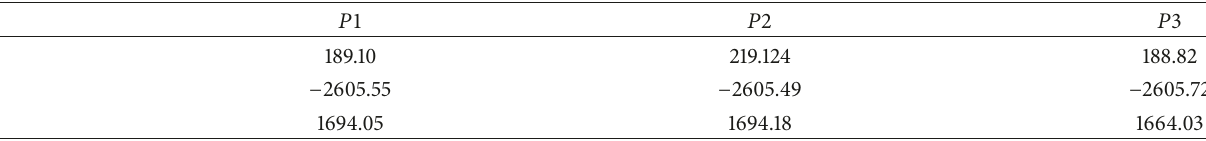
Table 10: Coordinates of base holes in robot coordinate system after changing coordinate